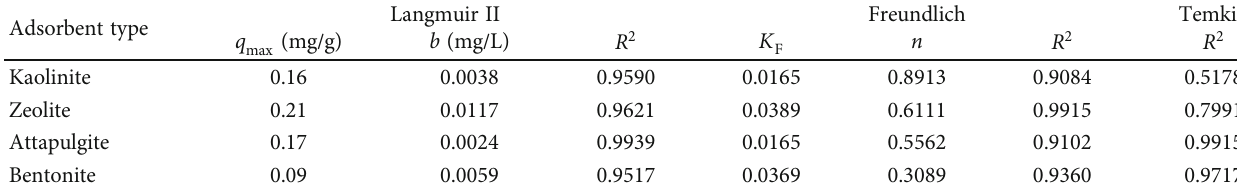
Table 5: Fitting results of the phosphate adsorption isotherm